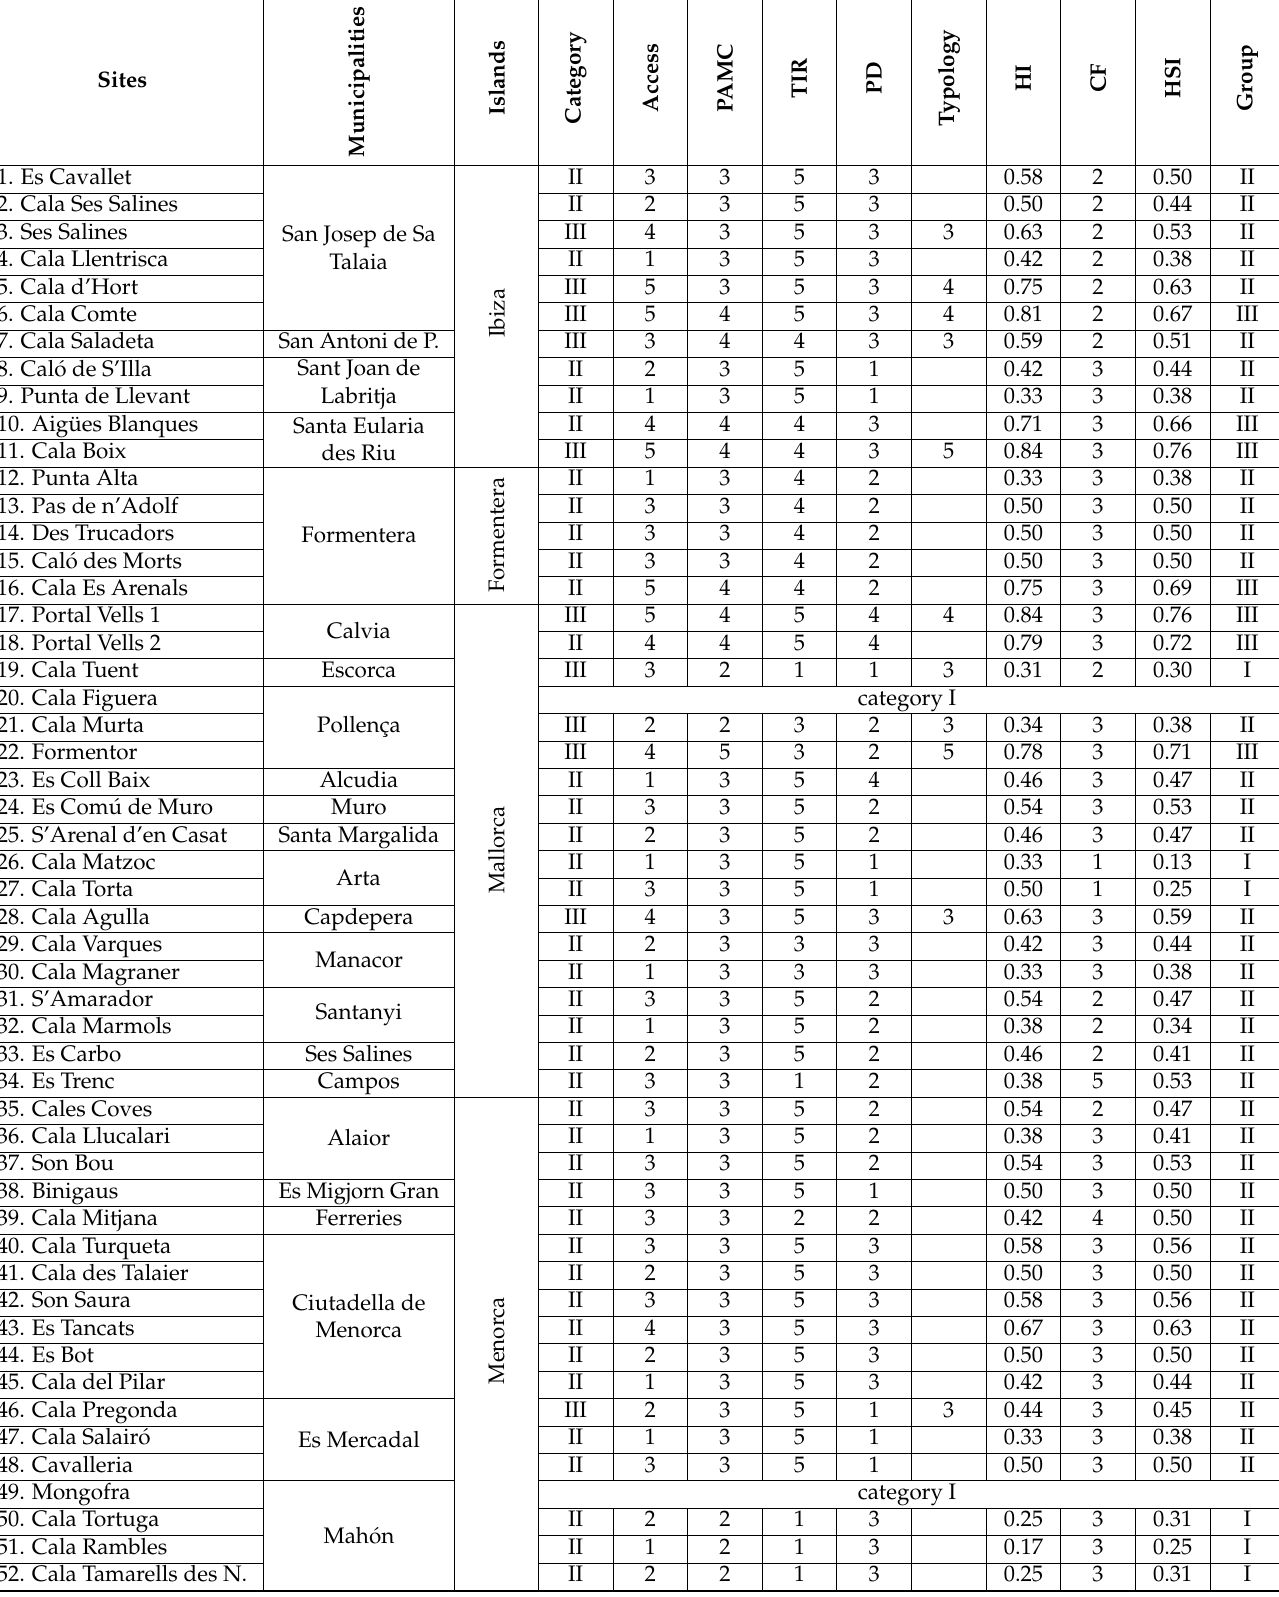
Table A4. Sites scores at human scenic sensitivity parameters (CSSI